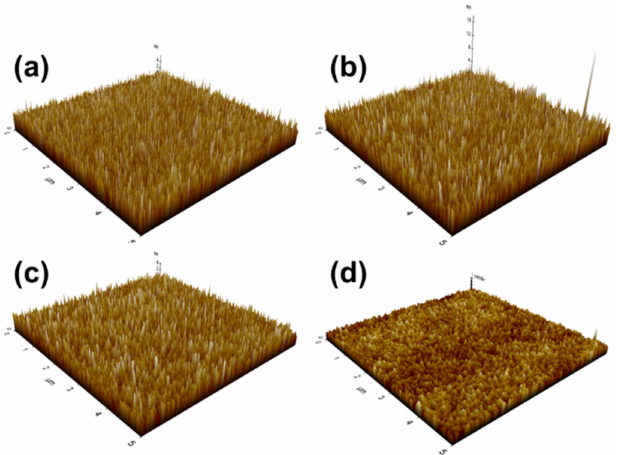
Figure 4. AFM surface image of SnO 2 thin film by annealing time; ( a ) as-deposited not annealed; ( b ) 1 h. annealed ( c ) 3-h annealed ( d ) 5-h